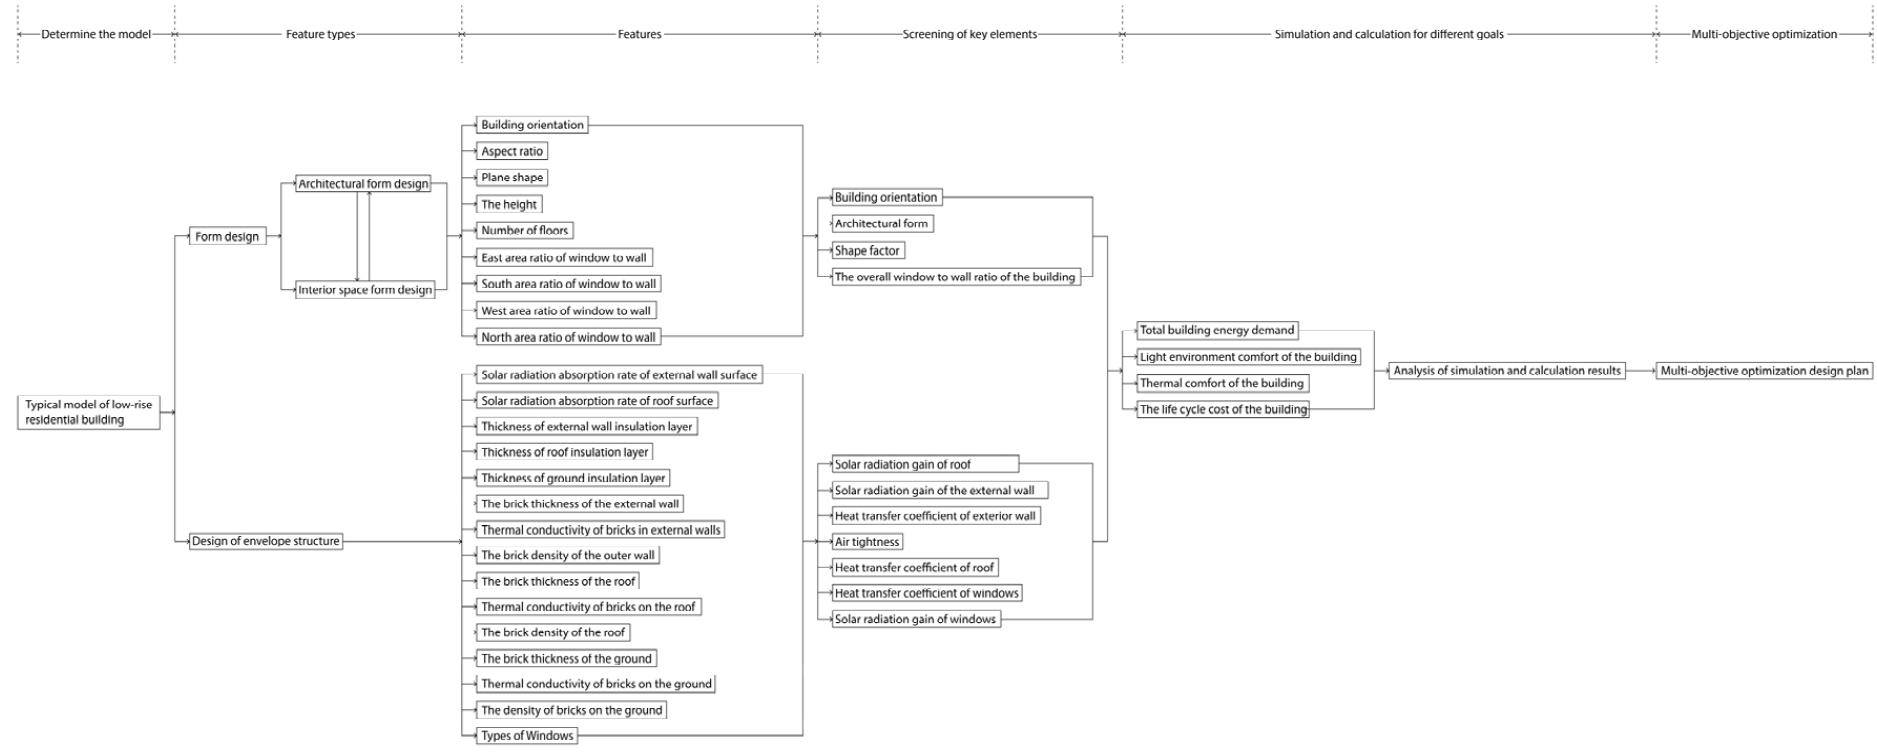
Figure 2. Multi-objective optimization method integrating design parameters of different